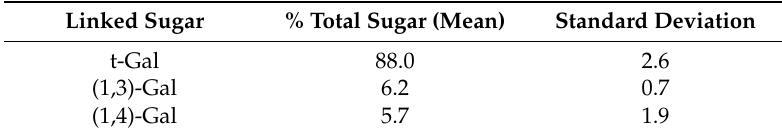
Table 1. Glycosidic linkage analyses of the oligosaccharidic fraction. Values are expressed as mole percentages of the total neutral sugar derivatives identified. Gal: Galactose. t: terminal. Linked Sugar % Total Sugar (Mean) Standard Deviation